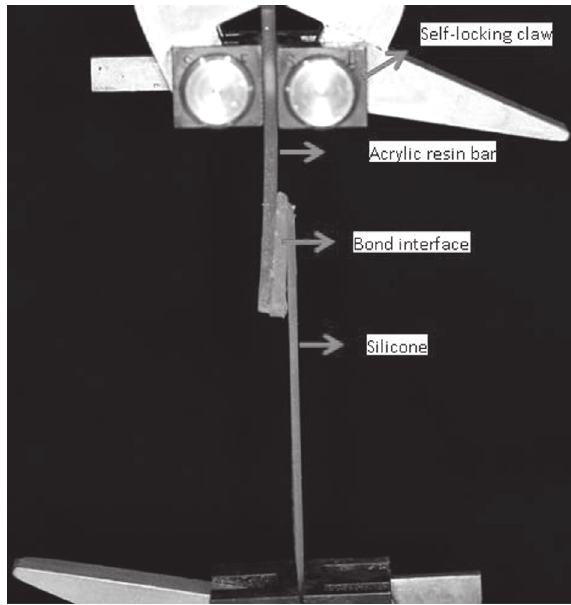
Table 2 - Three-way analysis of variance (ANOVA) for the T-peel strength values Source of variation